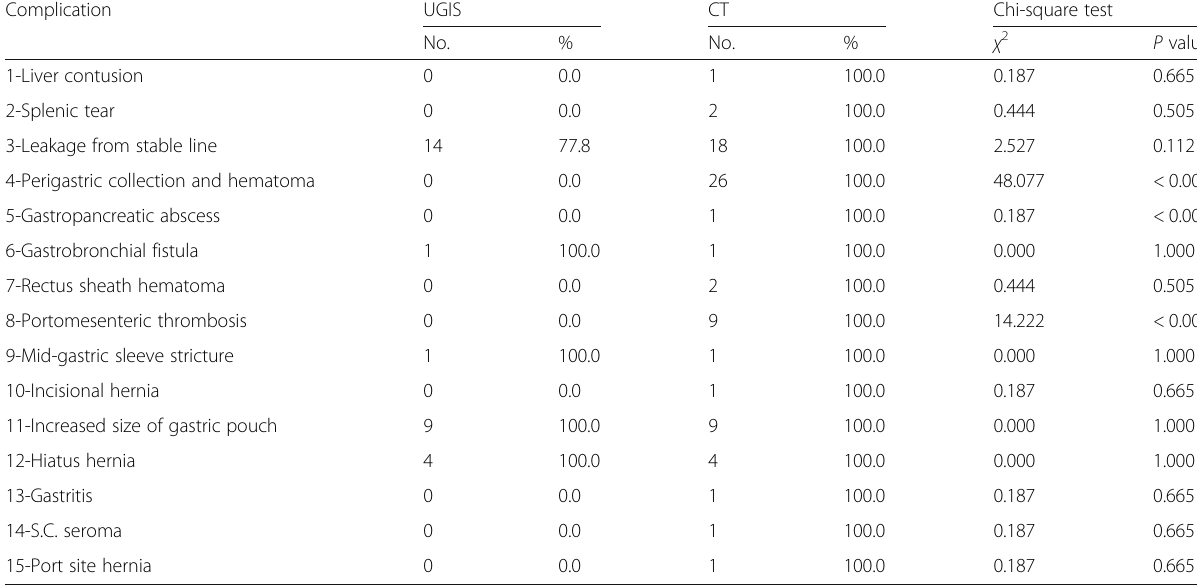
Table 5 Comparison of UGIS and CT in the detection of sleeve gastrectomy postoperative complications ( N = 78)